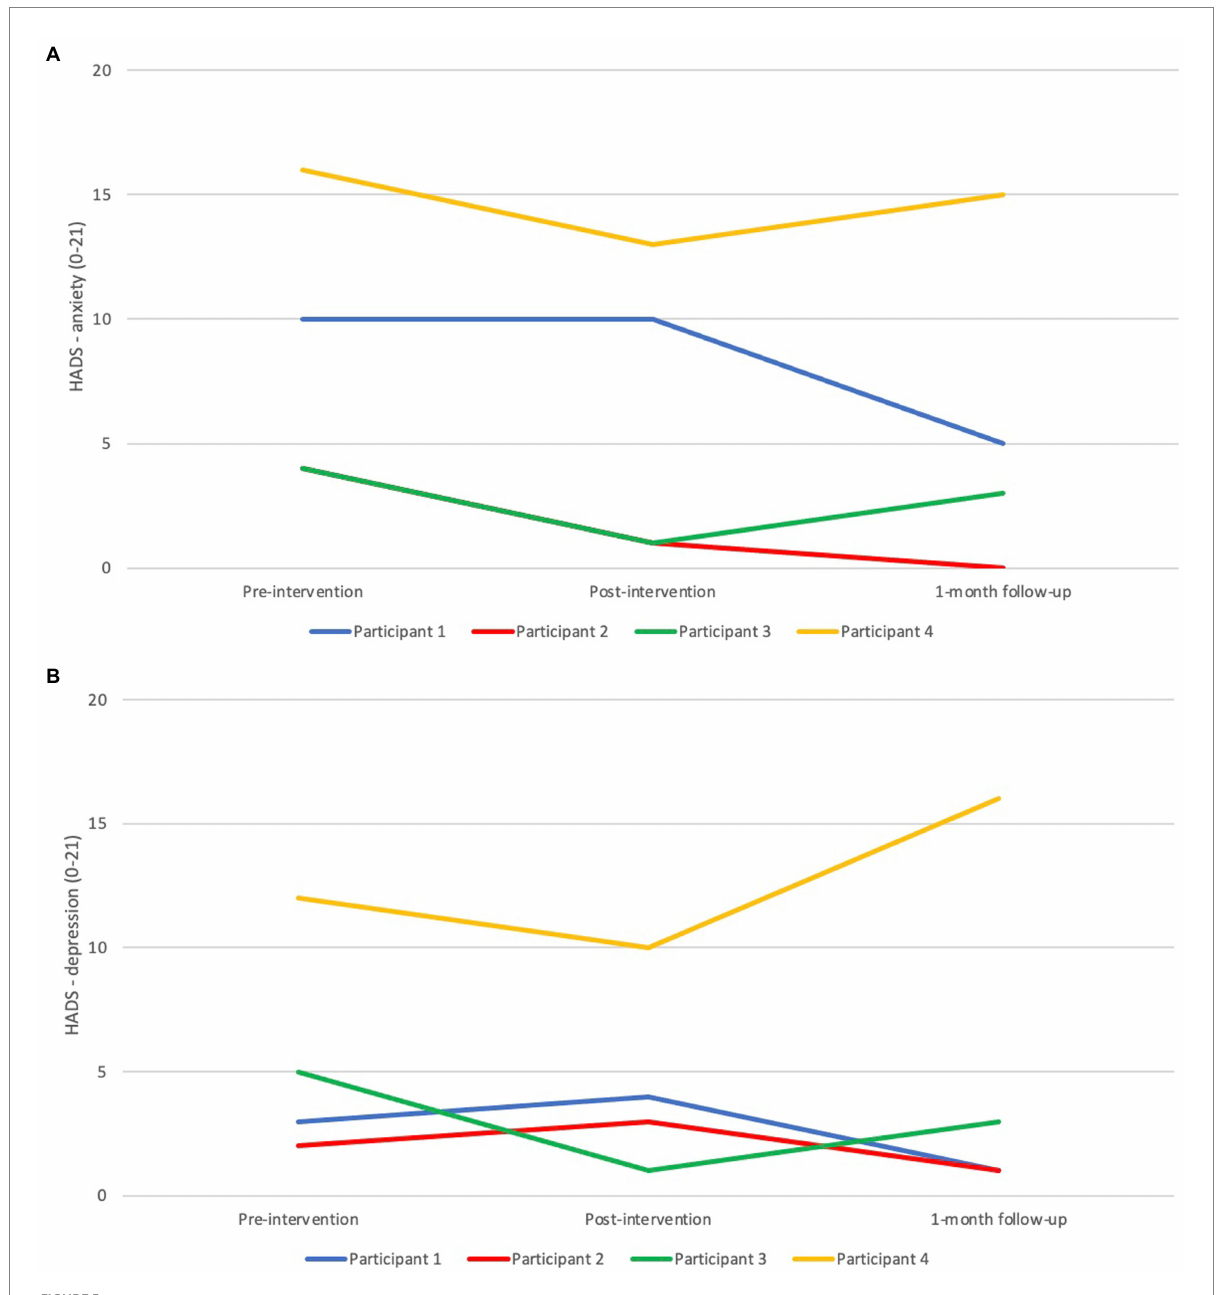
FIGURE 5 Pre-, post-, and 1-month follow-up assessments with (A) the Hospital anxiety and depression scale (HADS)—anxiety scale, and (B) the HADS— depression